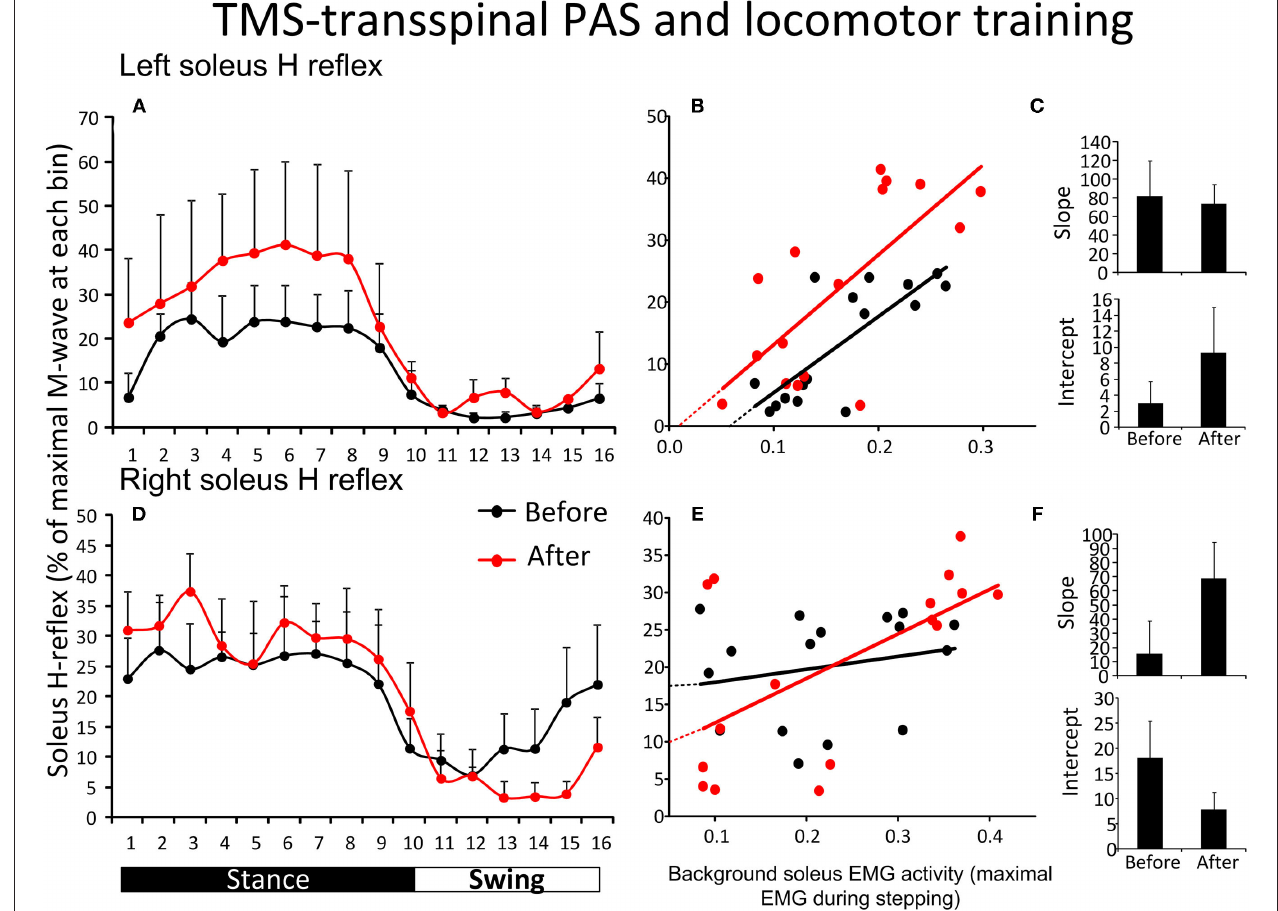
FIGURE 4 | Soleus H-reflex modulation during assisted stepping before and after TMS-transspinal PAS and locomotor training. The mean soleus H-reflex amplitude recorded from the left and right legs (A,D) before (black lines) and after (red lines) TMS-transspinal PAS and locomotor training, along with the soleus H-reflex amplitude plotted against the soleus EMG background activity (B,E) . The 16 points in graphs (B,E) correspond to the 16 bins of the step cycle. The overall amplitude of the slope and intercept for the left (C) and right (F) legs resulting from the linear relationship between the mean amplitude of the soleus H-reflex and EMG background. EMG, electromyogram; PAS, paired associative stimulation; TMS, transcranial magnetic stimulation. Error bars indicate the